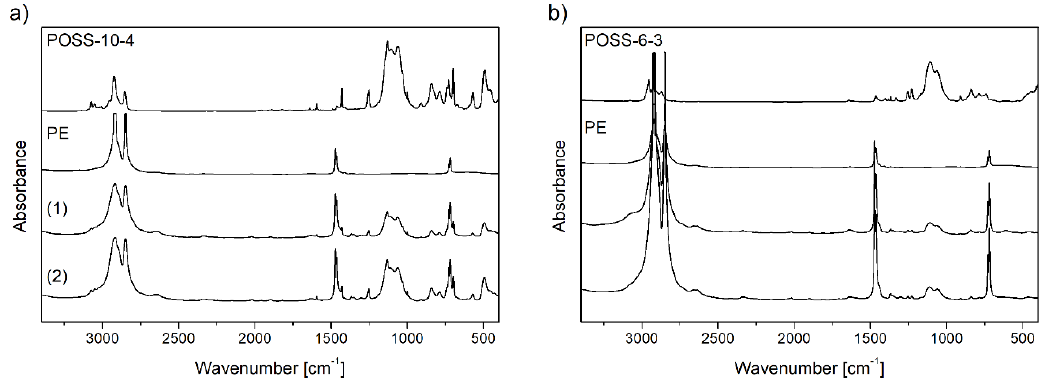
Figure 8. FT-IR spectra for neat POSS comonomers, polyethylenes, and E/POSS copolymers obtained over rac -Et(Ind) 2 ZrCl 2 under ethylene pressure of 0.2 MPa ( a ) and 0.5 MPa ( b ) at the concentration of the POSS comonomer in the reaction feed of: 1.67 × 10 − 3 mol/dm 3 (1) and 6.67 × 10 − 3 mol/dm 3 (2).